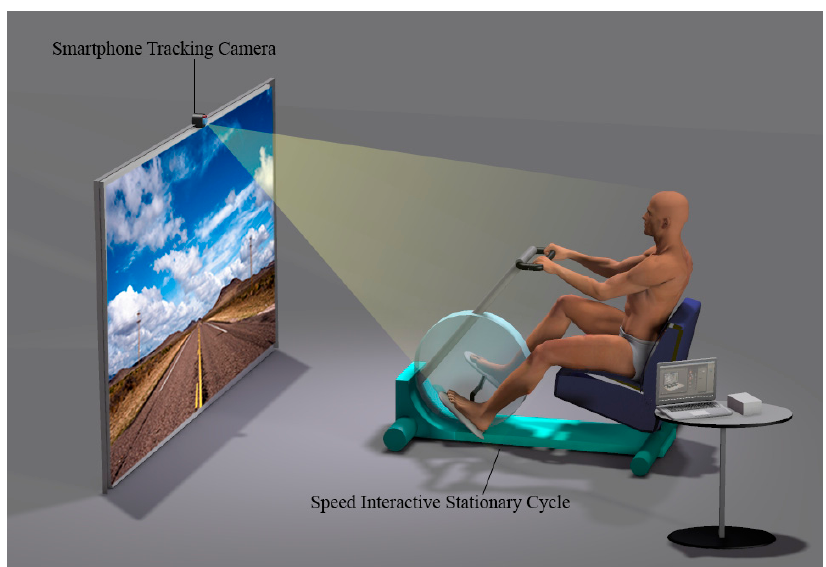
Figure 2. Motion tracking and speed-interactive pedaling training(SIPT) equipment.